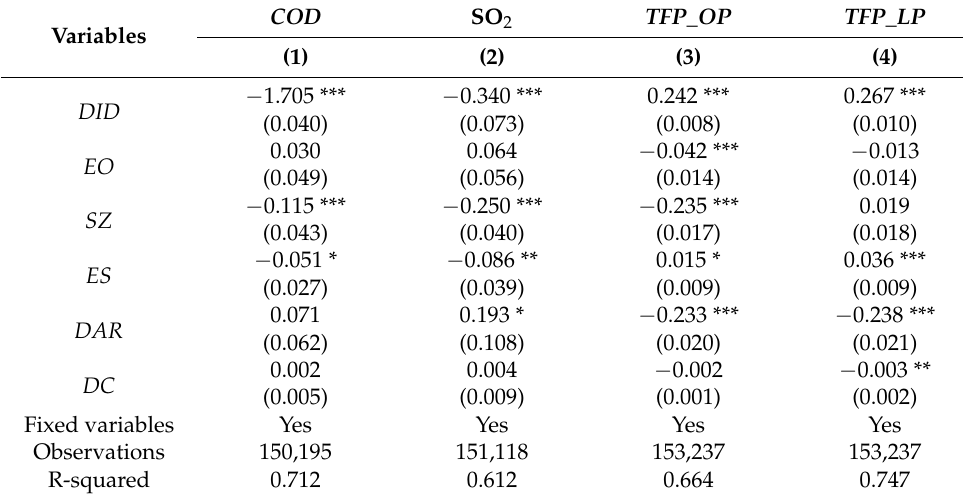
Table 2. Estimation results of the effect